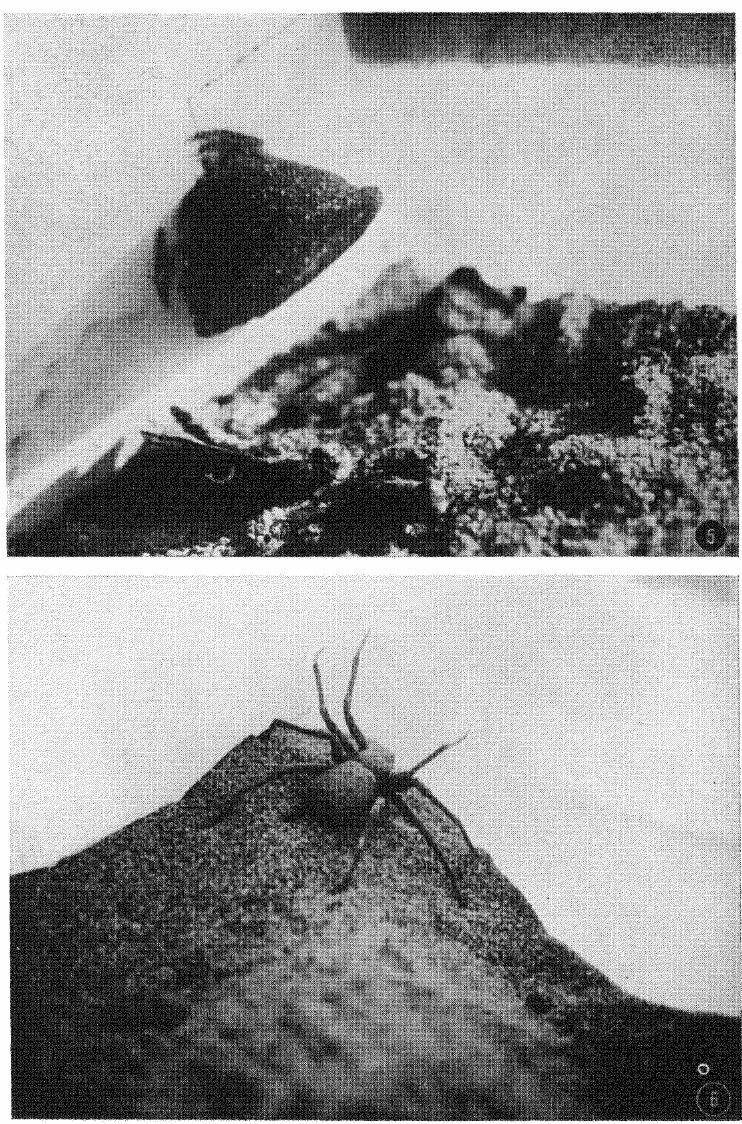
Fig. 5. The finished eggcase. The edge of the cap overhangs the walls. Photograph taken before the eggcase was buried, 15 June. Fig. 6. The eggcase has disappeared under the sand thrown over it. The line between 2nd and 3rd left legs of the spider’ is the same as the one in Fig. above and to the right of the